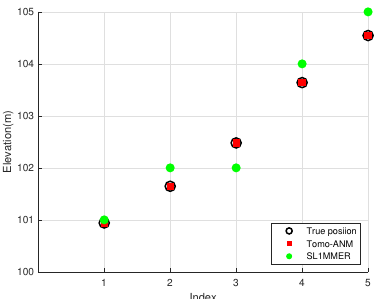
Figure 5. Removal of the off-grid effect by Tomo-ANM.